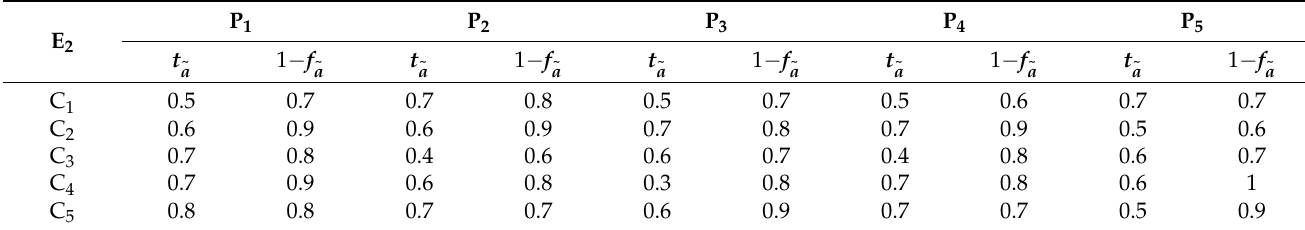
Table 15. Expert 2’s assessments on the different patients’